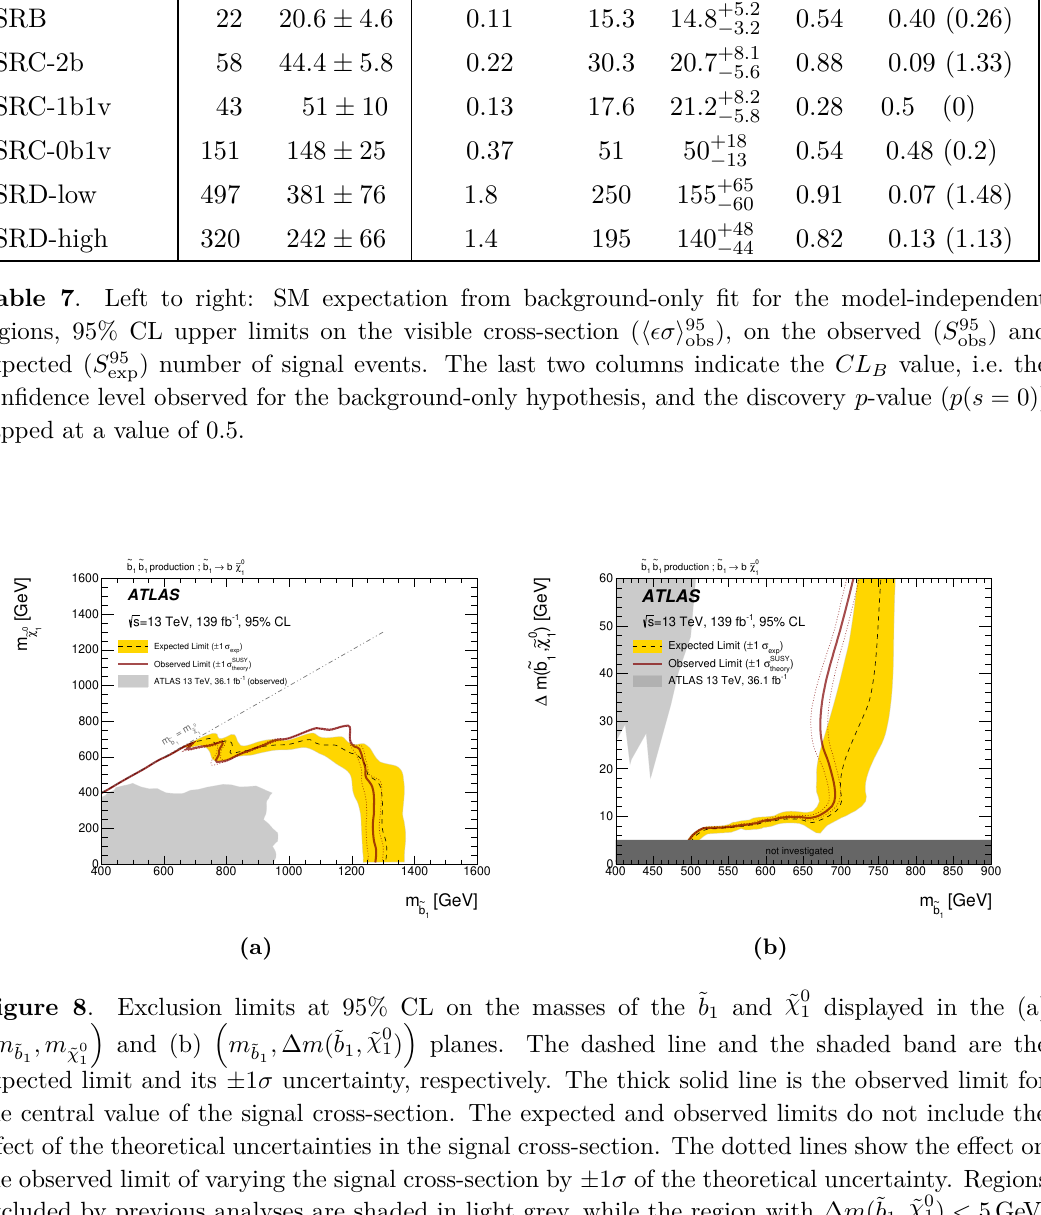
˜ Figure 8 . Exclusion limits at 95% CL on the masses of the b 1 and ˜ χ 0 1 displayed in the (a) (cid:16) (cid:17) (cid:16) (cid:17) (˜ and (b) planes. The dashed line and the shaded band are the m ˜ , m m ˜ , ∆ m b 1 , ˜ χ 0 1 ) ˜ χ 0 1 b 1 b 1 expected limit and its ± 1 σ uncertainty, respectively. The thick solid line is the observed limit for the central value of the signal cross-section. The expected and observed limits do not include the effect of the theoretical uncertainties in the signal cross-section. The dotted lines show the effect on the observed limit of varying the signal cross-section by ± 1 σ of the theoretical uncertainty. Regions ˜ χ 0 excluded by previous analyses are shaded in light grey, while the region with ∆ m (˜ b ) < 5 GeV, 1 1 , not investigated in this analysis, is shaded in dark